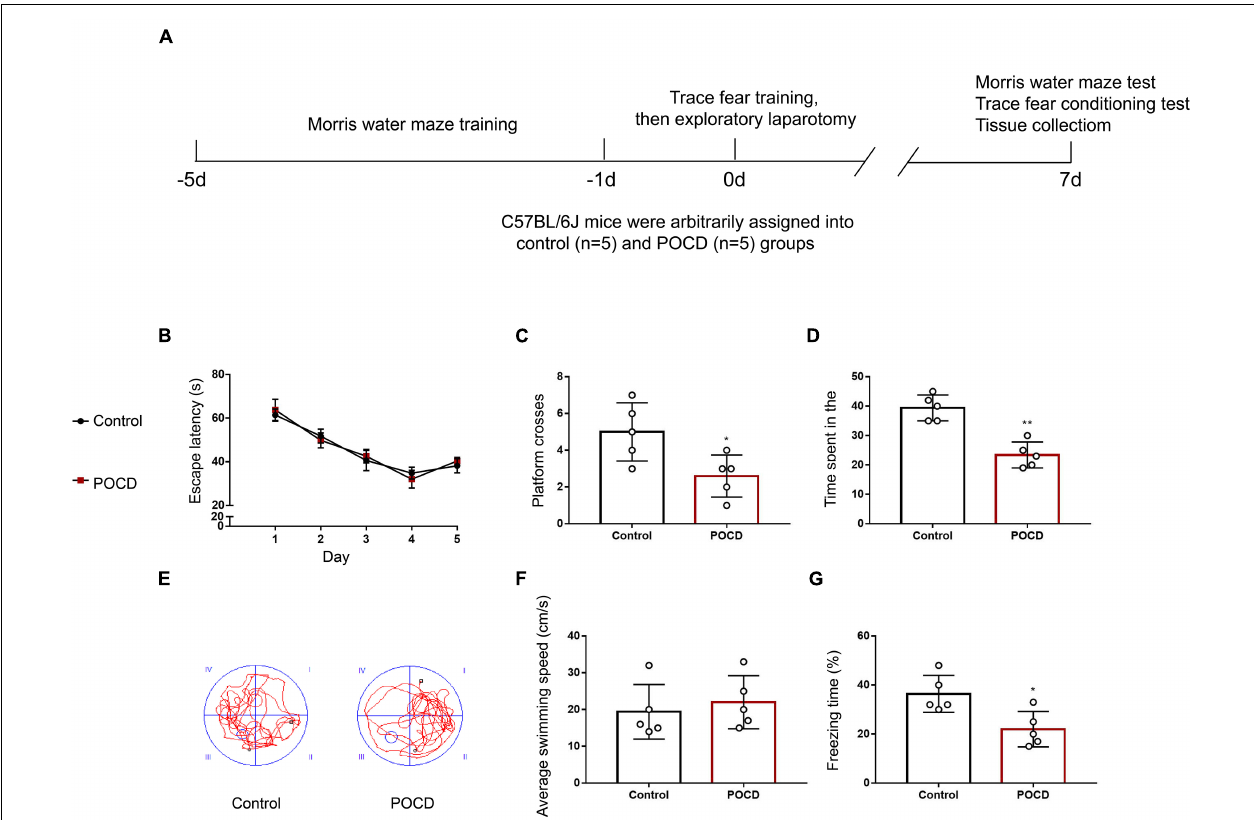
FIGURE 7 | Exploratory laparotomy successfully induces POCD in aged mice. (A) Diagram showing the timeline for behavioral tests and the operation. (B) Average escape latency for the training phase in the Morris water maze (MWM) test. (C) The number of platform-crossing events in the probe trial of the MWM. (D) The time spent in the target quadrant in the probe trial of the MWM. (E) Representative swimming traces of mice during the probe trial in the MWM test. (F) Swimming speed during the probe trial of the MWM. (G) Freezing time in the trace fear conditioning (TFC) test. All experiments were repeated three times. * p < 0.05, ** p < 0.01 vs. control group. The data are presented as the mean ± SEM ( n = 5).